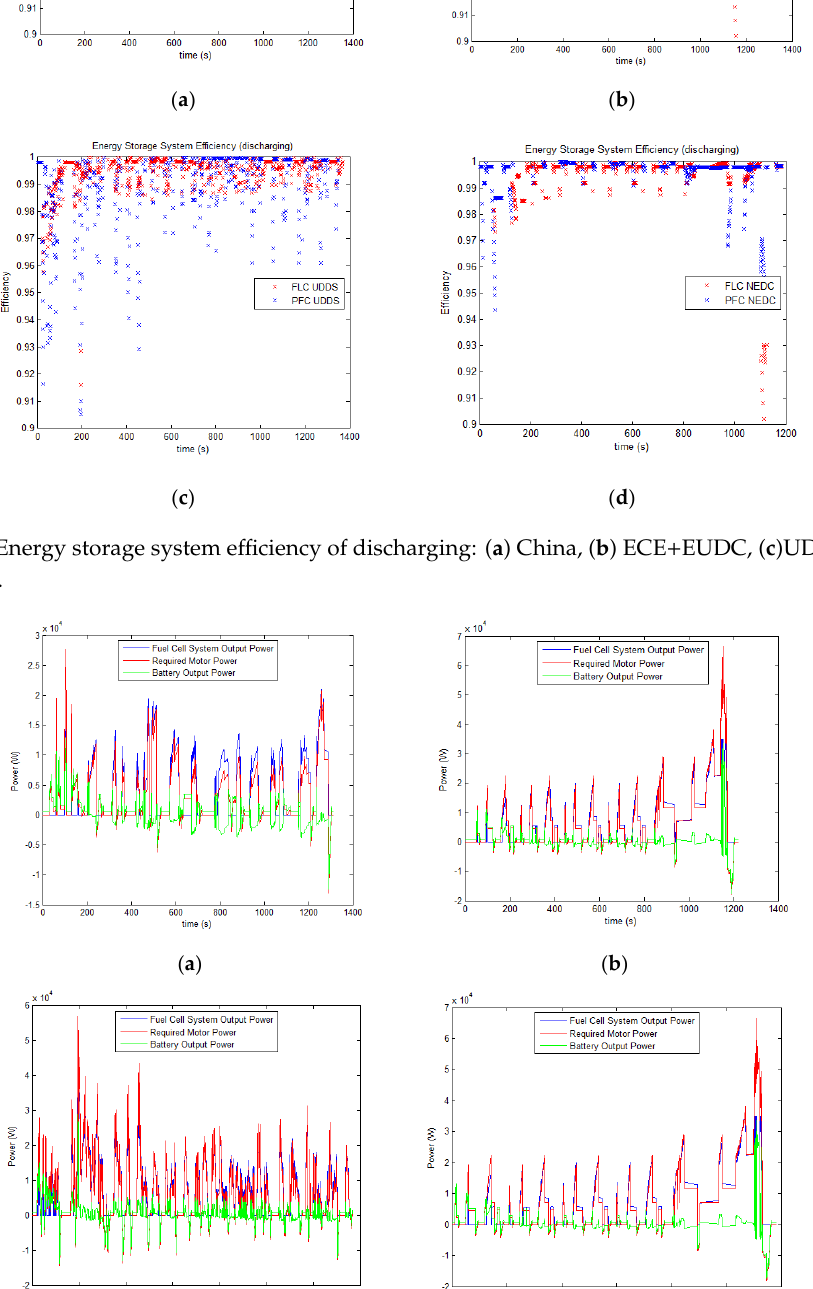
Figure 7. Power curves of afuel cell hybrid vehicle (FCHV): ( a ) China, ( b ) ECE+EUDC, ( c ) UDDS, and ( d ) NEDC.